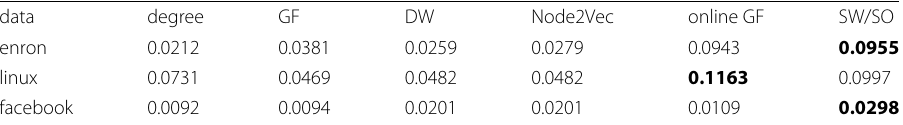
Table 6 Link prediction results with best parameter settings for each algorithm: batch: Graph Factorization (GF), Node2Vec, DeepWalk (DW), online: degree, online Graph Factorization (GF), and the best of StreamWalk (SW) and SecondOrder (SO)